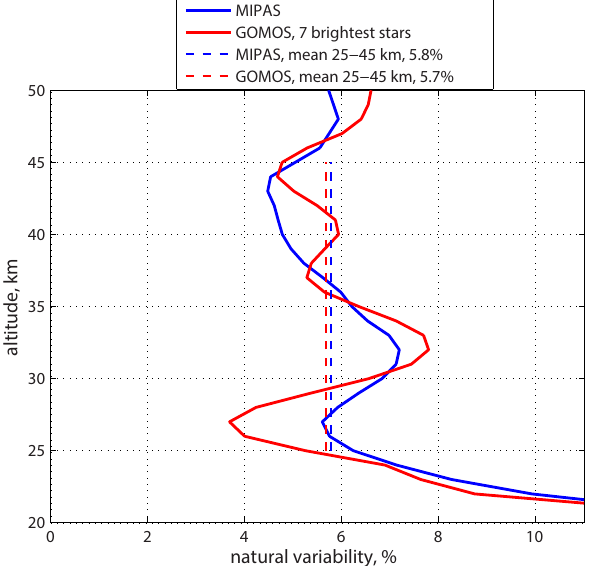
Figure 6. Profiles of natural variability at 20 ◦ S–20 ◦ N in 2008 (Eq. 5) using MIPAS nighttime data and GOMOS data from oc- cultations of seven brightest stars. Vertical dashed lines indicate the mean natural variability over the altitude range